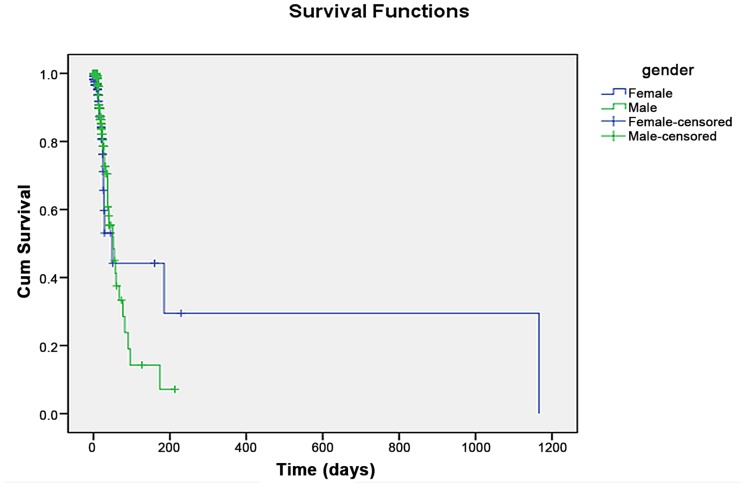
Plot of the Kaplan Meier Survival function curve for the data.